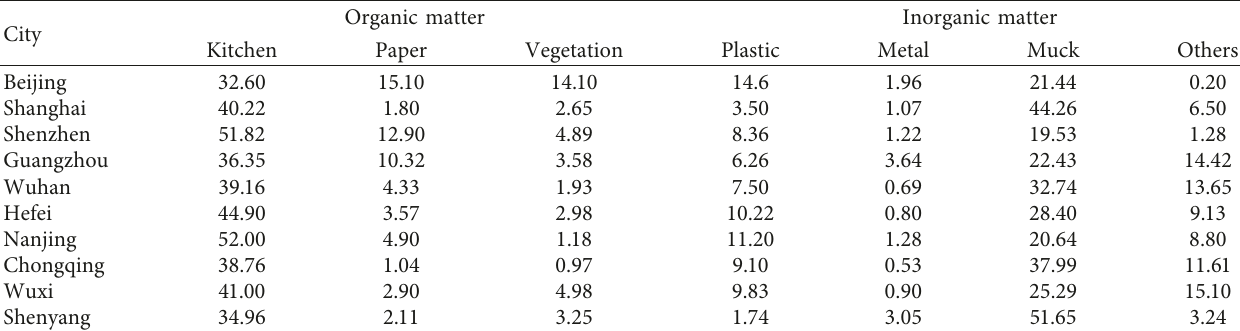
Table 1: Composition of MSW in some areas of China (%) [17].